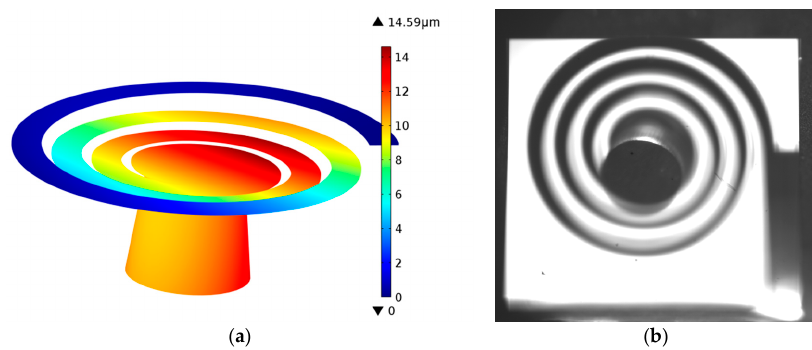
Figure 7. ( a ) Deflection distribution along the spiral cantilever at a driving acceleration of 1 g calculated by finite element analysis; ( b ) stroboscopic snapshot taken from the backside during shaking of the microspiral under optical microscope. The live slow-motion video clearly showed the off-axis wobbling movement of the seismic mass.